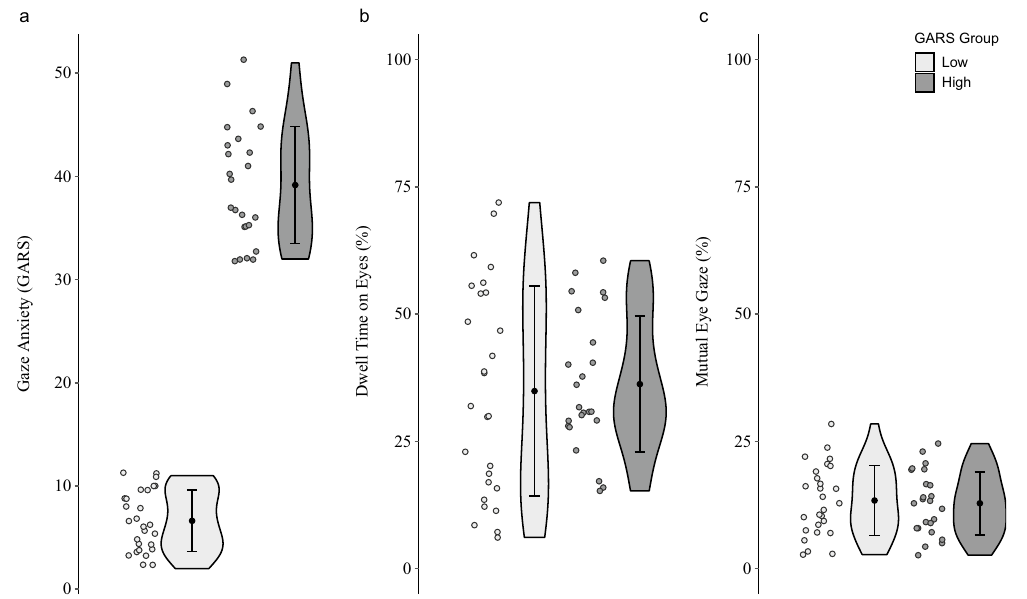
Figure 2. The effect of gaze anxiety on total dwell time on opponent’s eyes and mutual eye gaze for GARS group low and high. ( a ) Gaze Anxiety Rating Scale (GARS), ( b ) total dwell time on eyes ( c ) and mutual eye gaze for both GARS groups low and high. Data distribution is displayed with violin plots including mean (black dot) and standard deviation (brackets) and individual means for each participant. Gaze anxiety is displayed as a sum score, dwell time on eyes and mutual eye gaze as a percentage of total